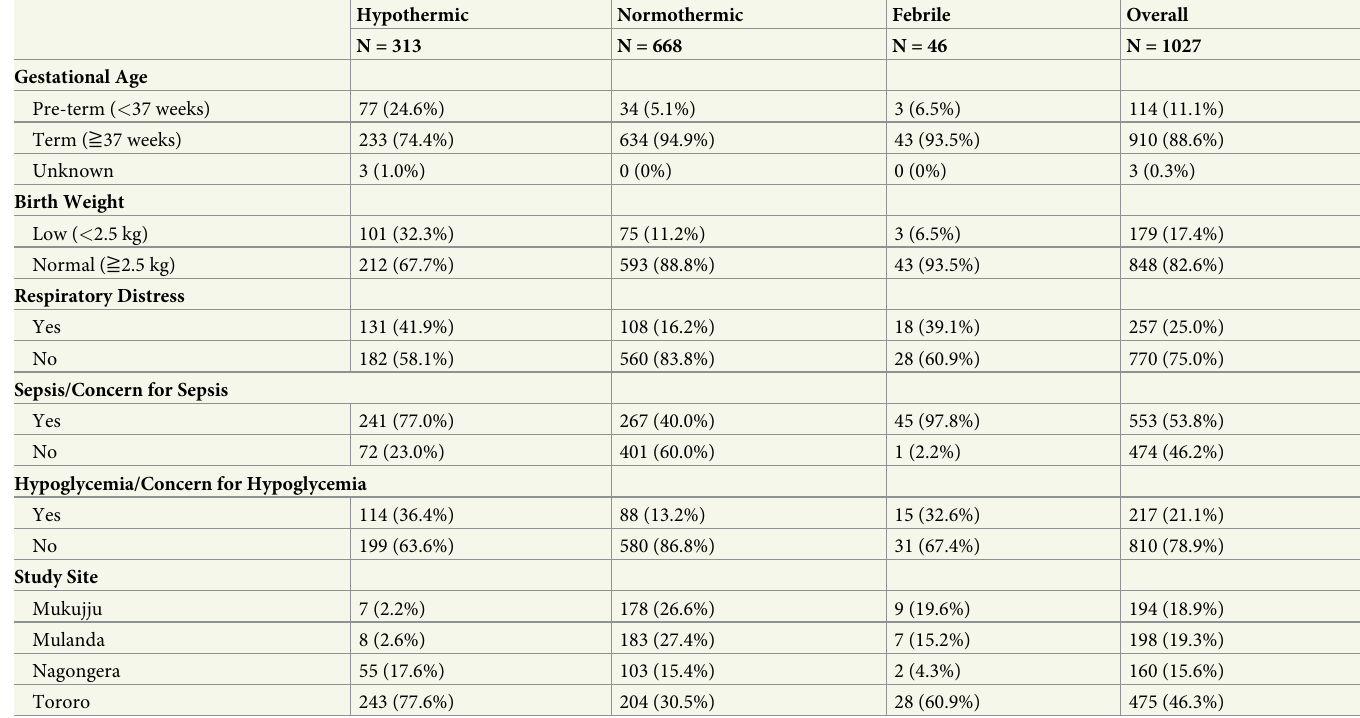
Table 1. Clinical characteristics of study population, by temperature. Hypothermic Normothermic